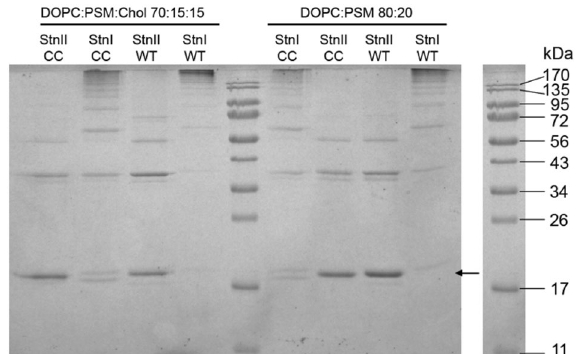
Figure 2. Results of the crosslinking experiments. The indicated Stn variant (CC indicates oxidized double-Cys mutant) was first incubated with LUVs of the indicated composition for 30 min, and then with 10 min with DSS. The expected position of the monomers (~ 19 kDa) in indicated with a small arrow. M w of the proteins in the ladder are shown on the